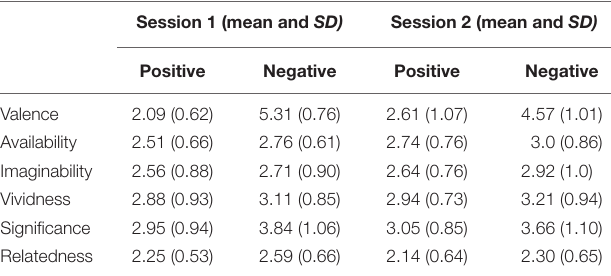
TABLE 1 | Showing mean ratings for characteristics of positive and negative memories in session 1 and session 2. Session 1 (mean and SD) Session 2 (mean and